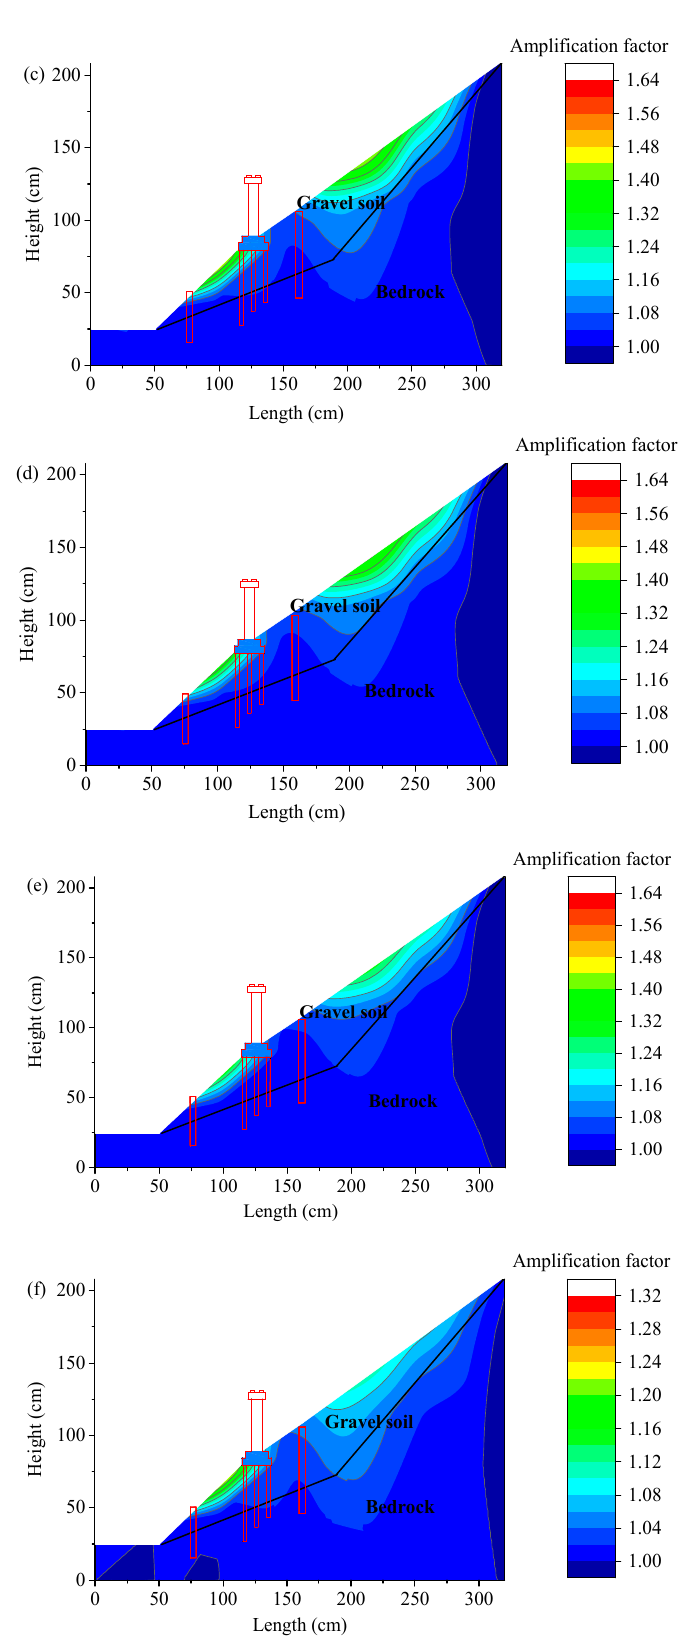
Figure 16. Peak ground acceleration (PGA) amplification factor distribution equipotential maps of slope with different seismic inputs. ( a ) 0.1 g; ( b ) 0.2 g; ( c ) 0.3 g; ( d ) 0.4 g; ( e ) 0.5 g; ( f) 0.6 g.